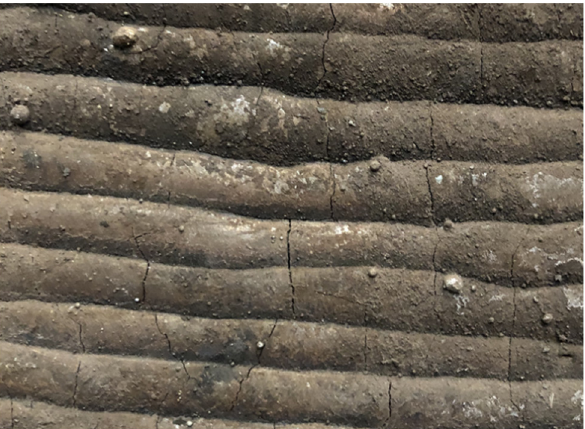
Figure 8. Repaired roller surface. Table 7. Hardness experiment results.